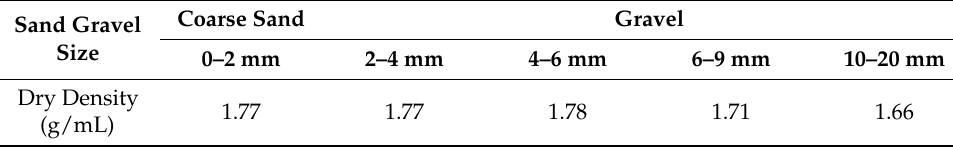
Figure 1. Experimental sandy gravel particle grading curve. 129 Table 4. Sand gravel material physical characteristics. 130